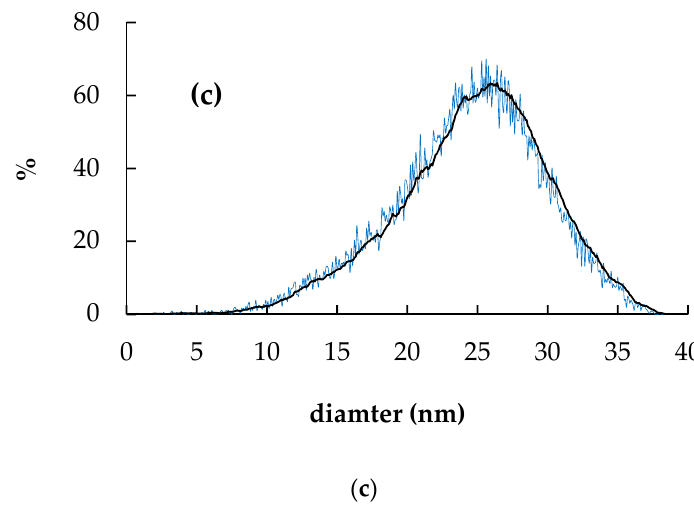
Figure 1. ( a ) TEM image of CNF isolated from bleached palm fruit stalks pulp, ( b ) AFM image of CNF and ( c ) diameter distribution curve of the CNF measured.